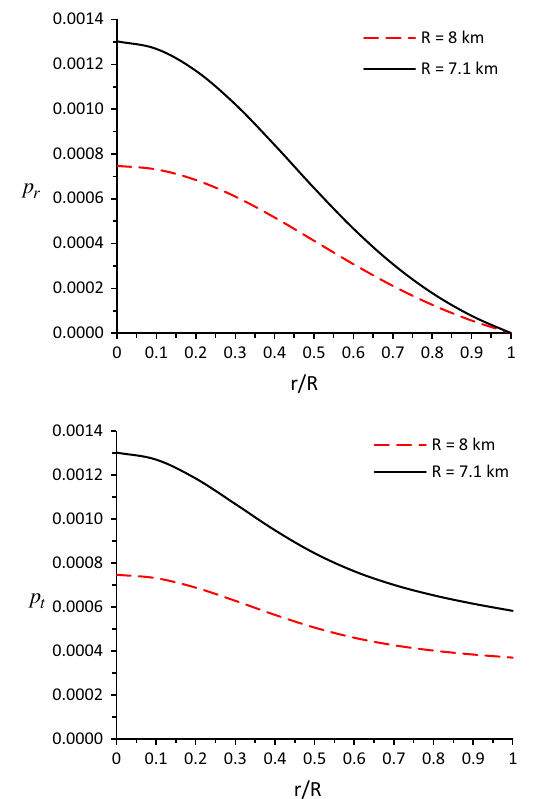
Fig. 3 Behavior of density ( ρ ) and anisotropy factor ( Δ ) versus radial coordinates r / R . For plotting of this figure, the corresponding values of arbitrary constants or parameters are displayed in Table